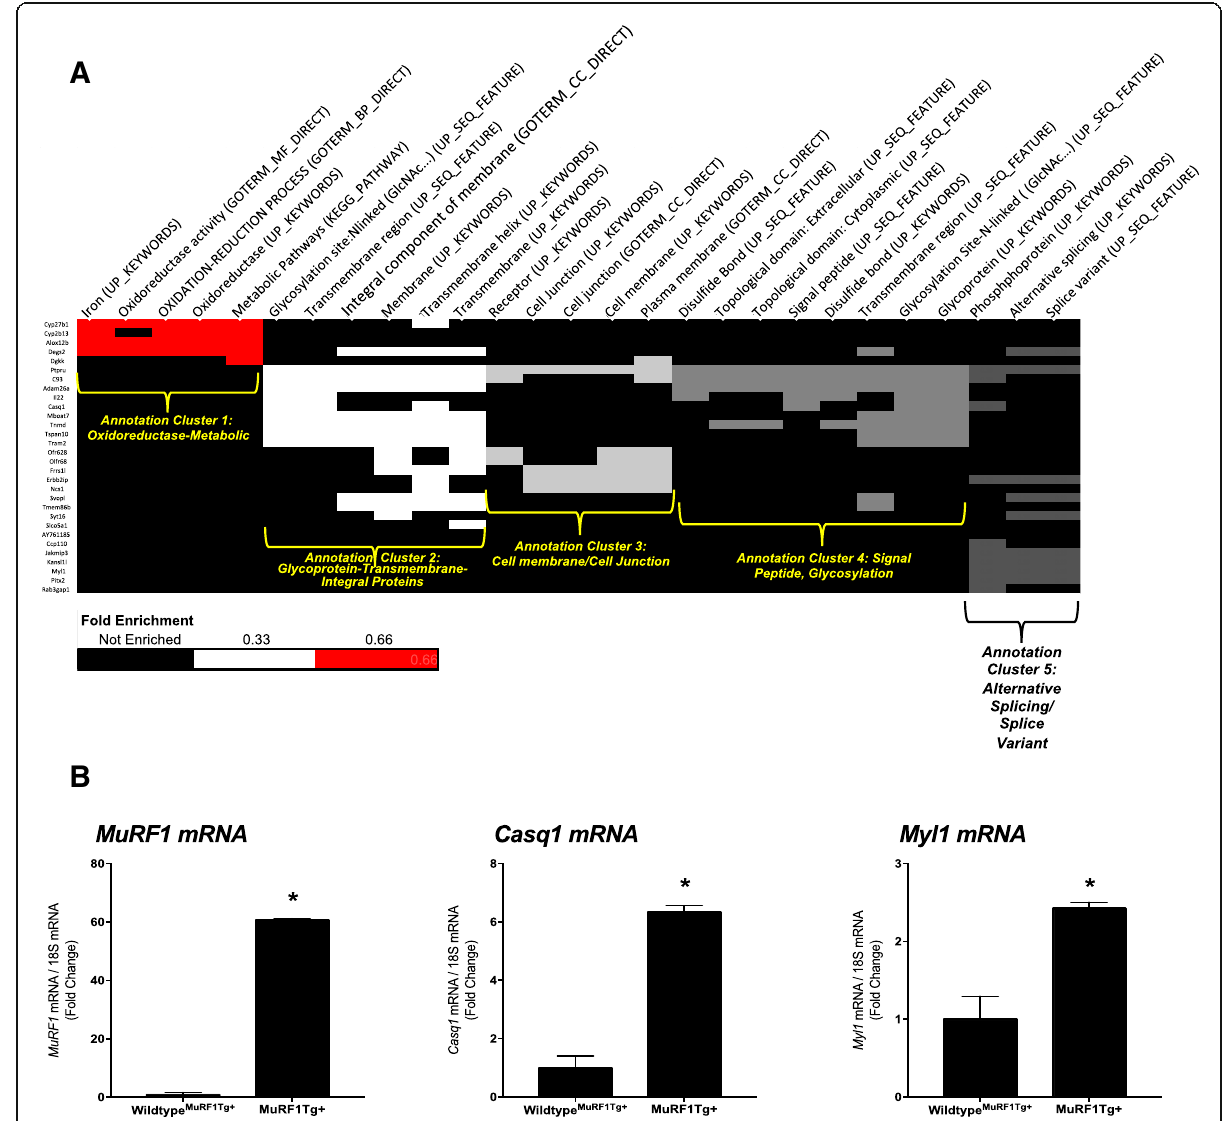
Fig. 5 Functional annotation of differentially expressed genes in MuRF1 Tg + hearts compared to wild-type controls. a. Hypercluster analysis of differentially expressed MuRF1 − / − genes in the right ventricle after hypoxia challenge using the DAVID v6.8 Functional Annotation Bioinformatics database. Differentially expressed gene symbols are on the left, functional categories along the top (database source in parentheses). The cluster fold enrichment is color-coded (key in lower left). b. Reverse transcriptase quantitative PCR analysis of MuRF1 − / − hearts of differentially expressed genes MuRF1, Casq1 , and Myl1 mRNA in the right